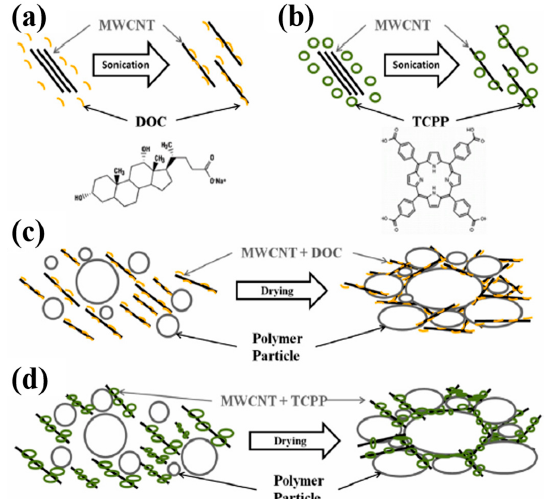
Figure 6. The dispersed multi ‐ walled carbon nanotubes (MWNT), when mixed with polymer emulsion particles, forms a three ‐ dimensional network in the interstitial positions between the polymer particles. ( a , b ) show representations of the dispersed MWNT in the two stabilizing agents, DOC and TCPP. ( c , d ) illustrate the formation of a segregated network upon the drying of the water ‐ emulsions. Reprinted with permission from [54]. Copyright 2012